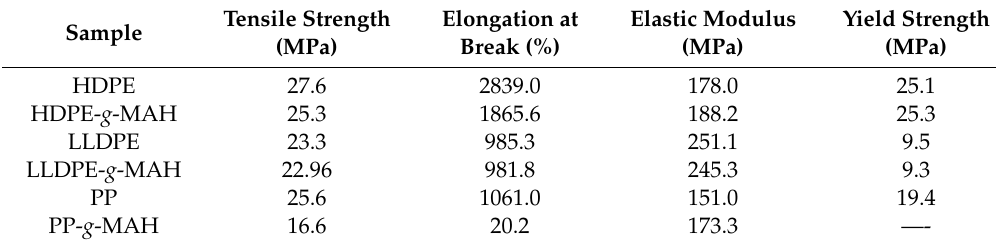
Figure 4. Stress and strain curves of ( a ) LLDPE, LLDPE- g -MAH, HDPE, HDPE- g -MAH; ( b ) PP and PP- g -MAH. Table 4. Mechanical properties of polyolefins and